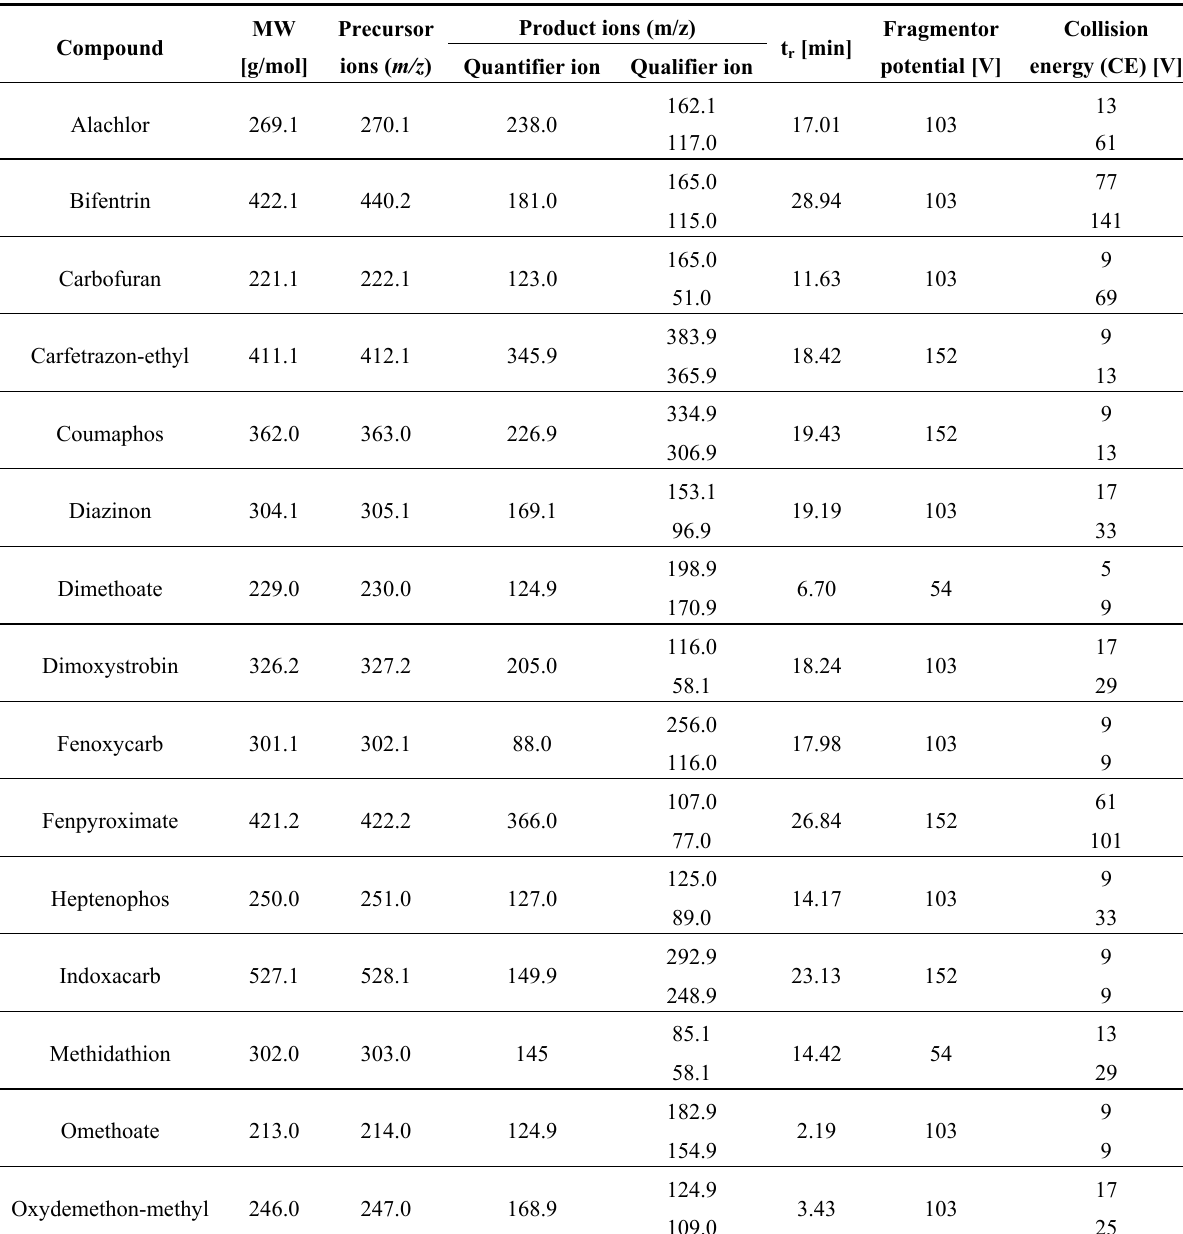
Table 3. Multiple reaction monitoring parameters of the studied compounds (dMRM: delta retention time 1 min, except for alachlor 2